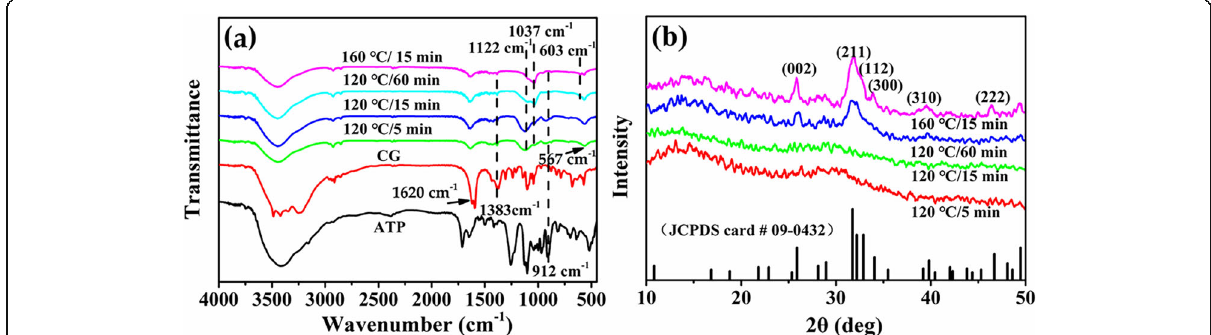
Fig. 5 a FTIR spectra and b XRD patterns of ATP-CG microspheres synthesized with Ca/P = 3.3 under different experimental